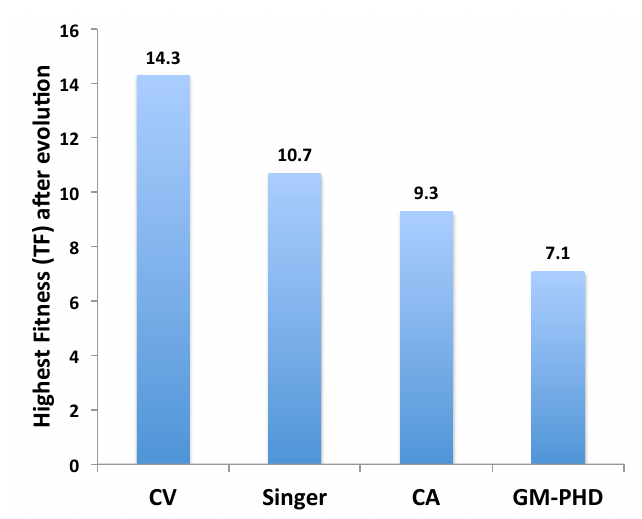
Figure 7. Highest fitness (TF degrees) after evolution of four tracking algorithms (with noise).